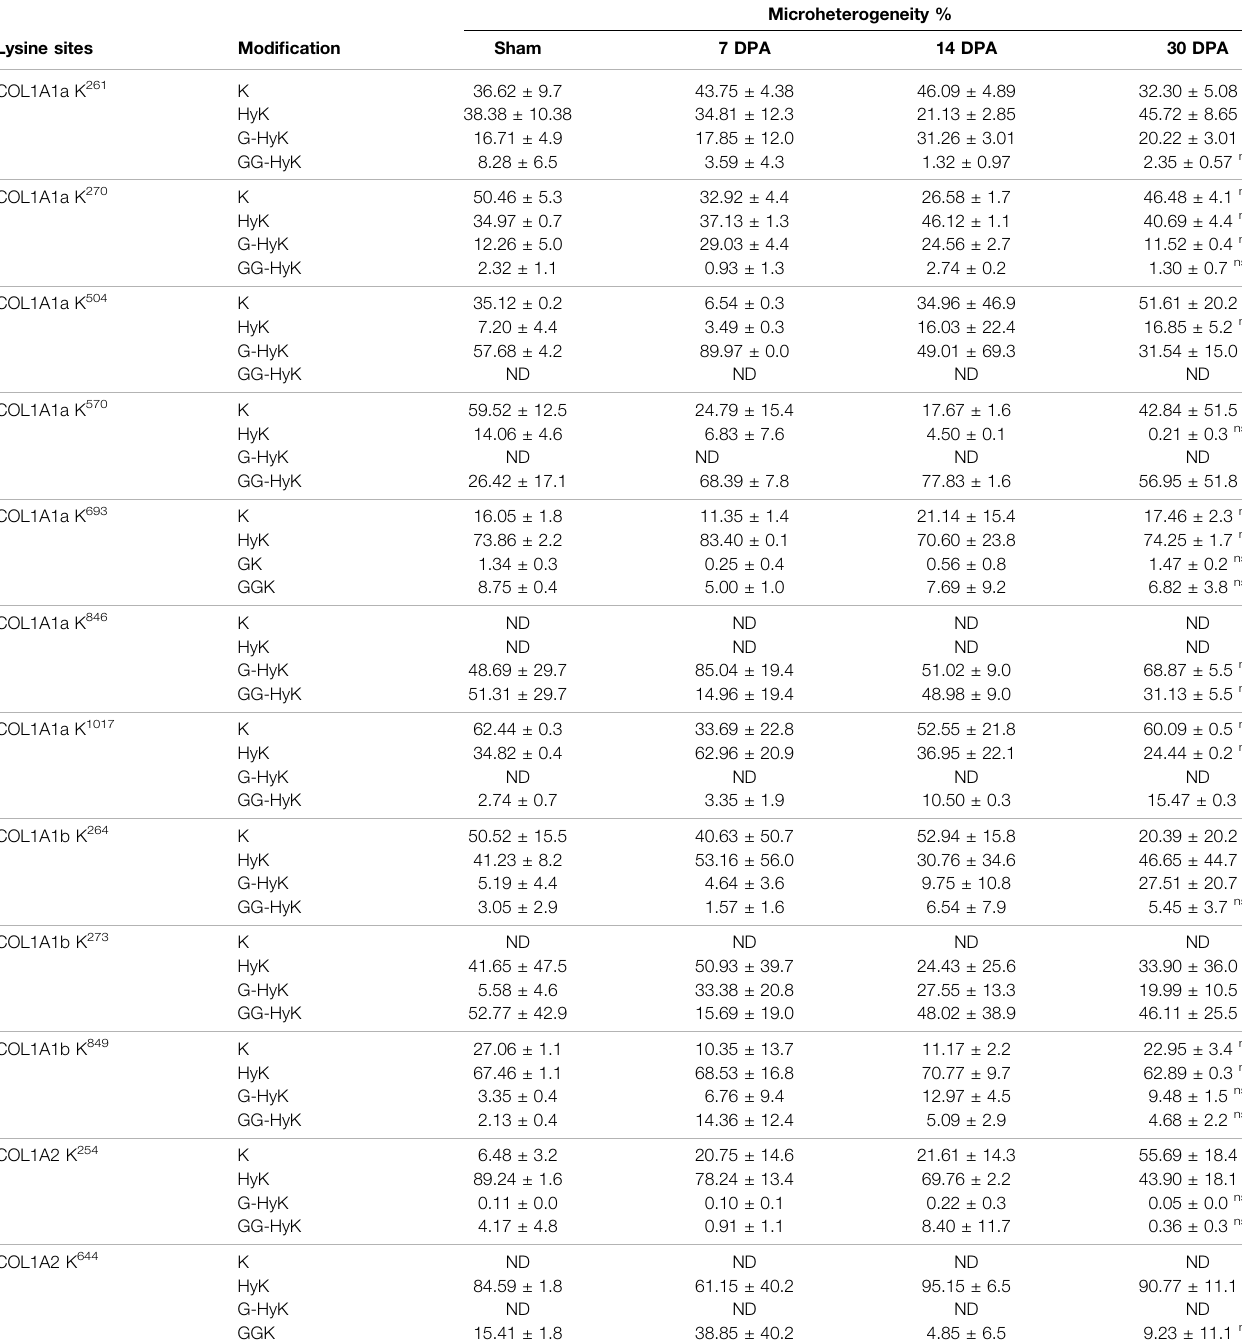
Microheterogeneity %